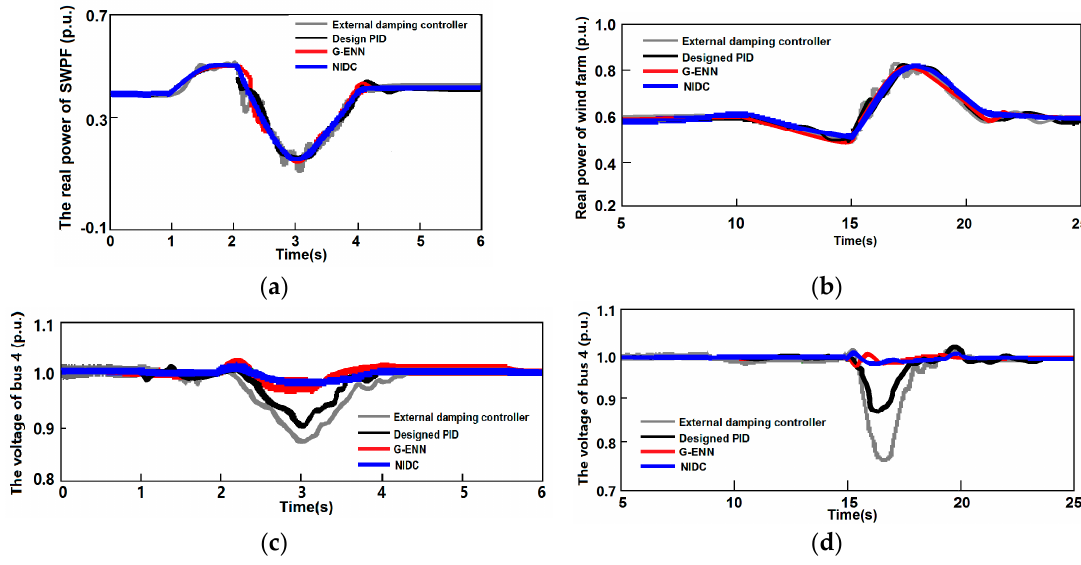
Figure 11. The responses of dynamic stability for Case 3 ( a ) The real power of SWPF; ( b ) The real power of OWF; ( c ) The voltage of bus 4 when SWPF air velocity changes; ( d ) The voltage of bus 4 when OWF speed changes.